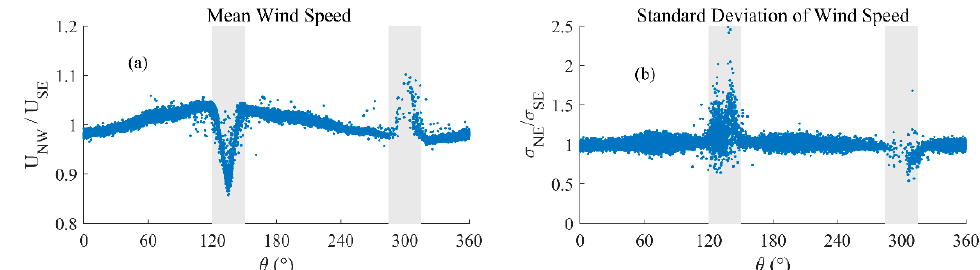
Figure 2. Comparison of wind speed characteristics between the paired cup anemometers installed on the mast. Wind direction ranges affected by mast interference effect are shaded. ( a ) 10-min mean wind speed ( b ) standard deviation of wind speed